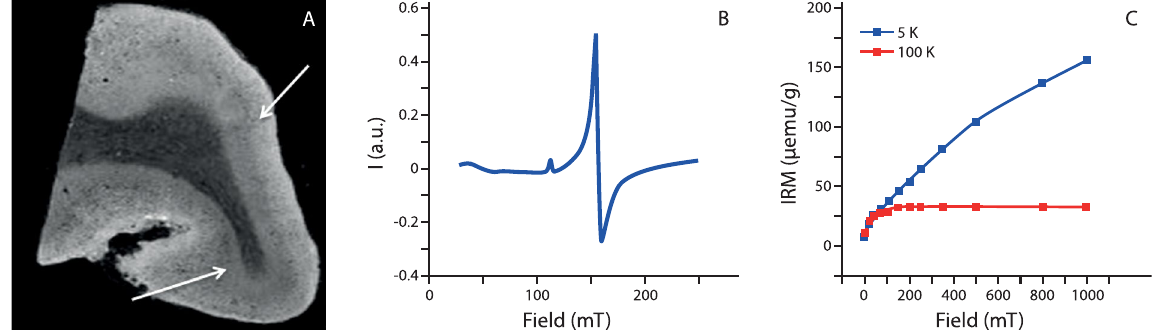
Figure 1. Example of raw data obtained from this study. Panel A shows the MRI scan (third echo of the Multi- Gradient-Echo scan). Some dark bands are observable in the grey matter, and indicated by white arrows. Panel B shows the smoothed EPR spectrum obtained from the same subject. Panel C illustrates the IRM data measured with the SQUID magnetometer at 100 K (red curve), showing the presence of magnetite/maghemite, and 5 K (blue curve), attributed to the presence of